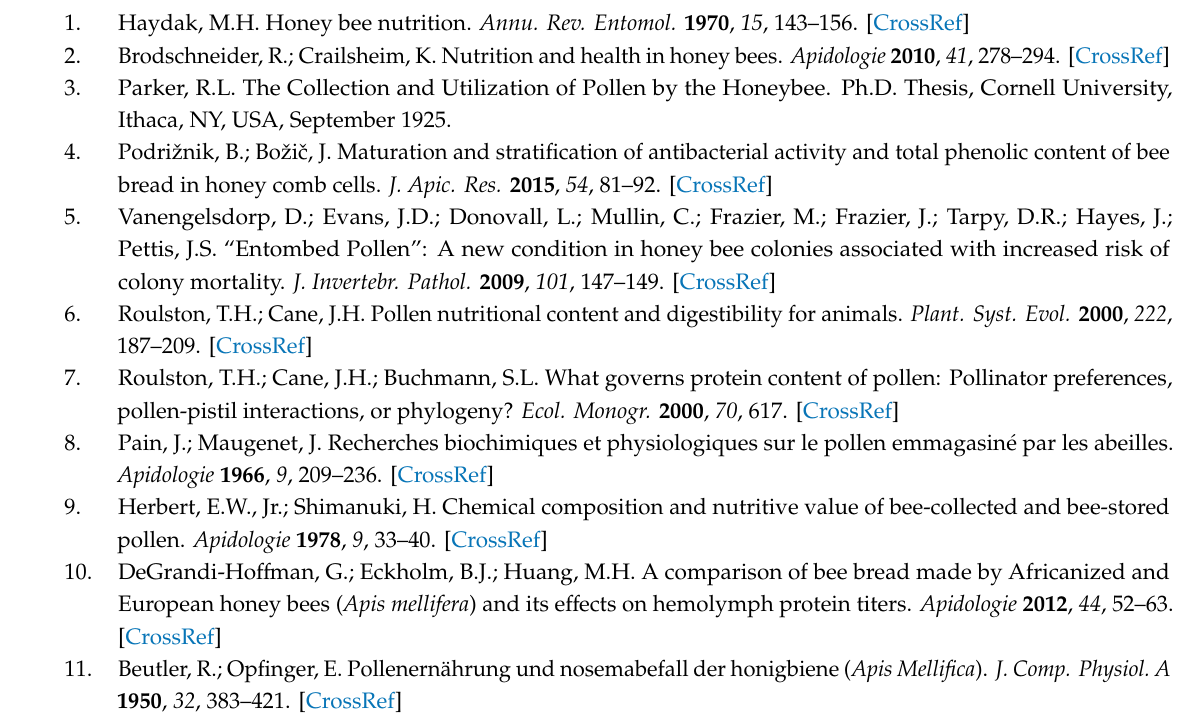
Table S1: Samples and their origin, weight, species, and colony counts, Table S2: Isolates, MUCL collection numbers, GenBank accession numbers, sequence similarities leading to their identification, Table S3: D1 / D2 LSU sequence similarity of Debaryomyces hansenii group isolates, Table S4: D1 / D2 LSU sequence similarity of Metschnikowia cf. pulcherrima